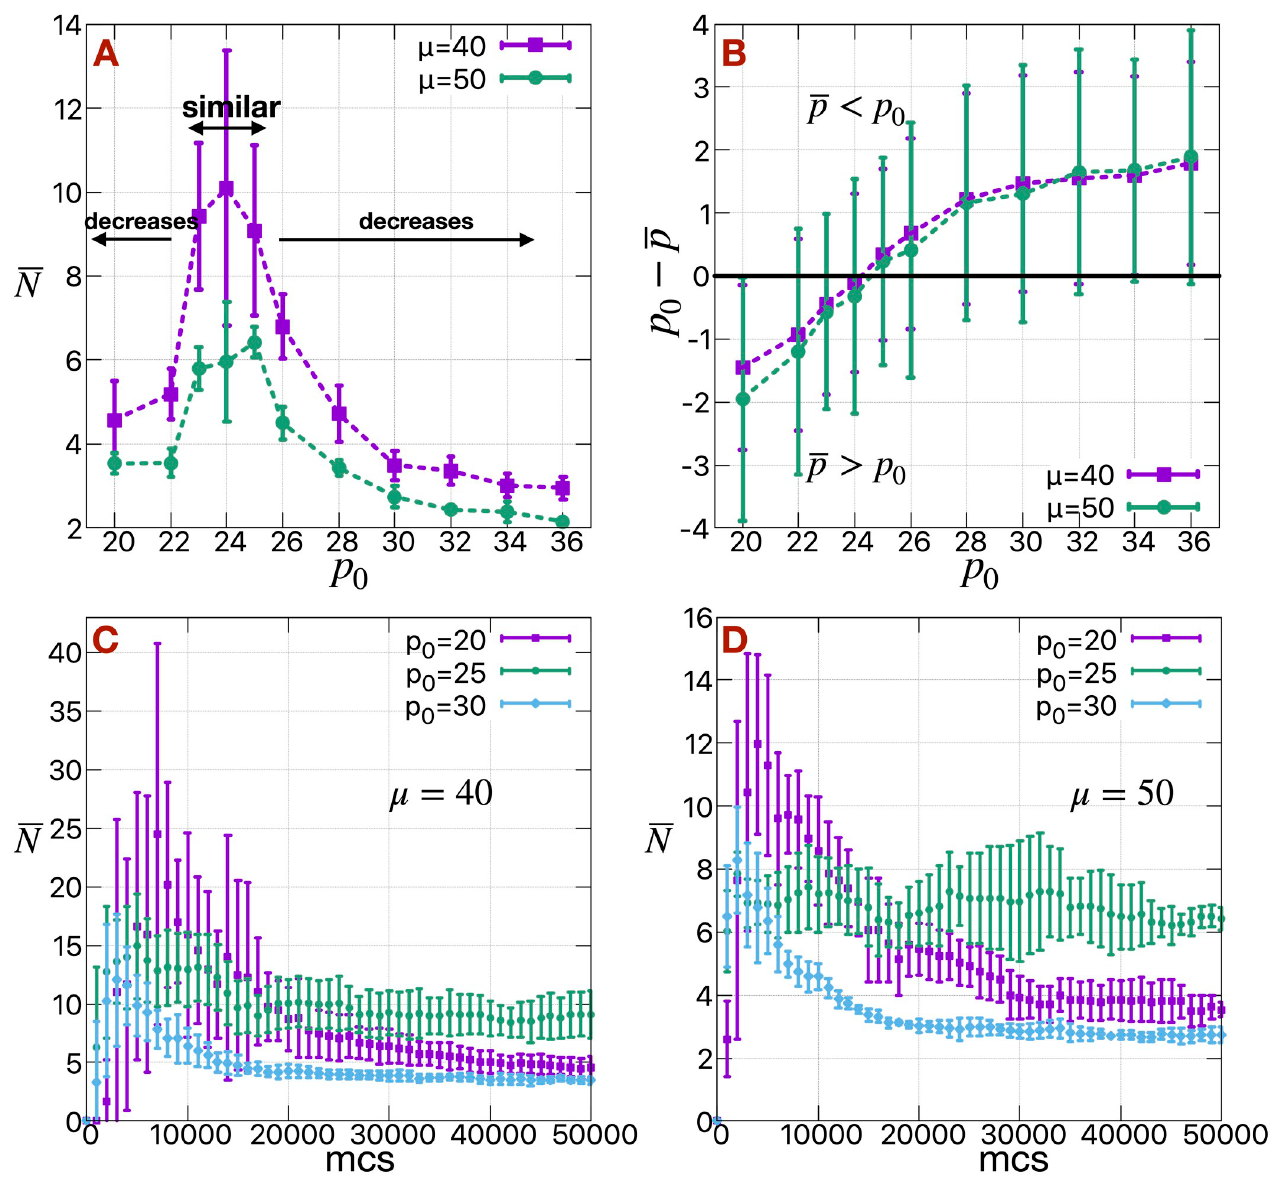
Fig 8. Effect of cell shapes on cluster sizes. (A) The mean cluster size ( N ) of H cells as a function of targeted perimeter of the H cells ( p 0 ) for different values of μ at Γ = 3 calculated at mcs = 50000. N is similar for p 0 = [23, 25] and decreases gradually with either an increase or decrease in p 0 . (B) The difference in targeted perimeter and mean obtained perimeter of H cells ( p (cid:0) p ) as a function of p 0 . The corresponding time series of mean cluster size ( N ) of H cells for 0 different values of p 0 at (C) μ = 40 and (D) μ = 50. We use standard deviations of the data as error